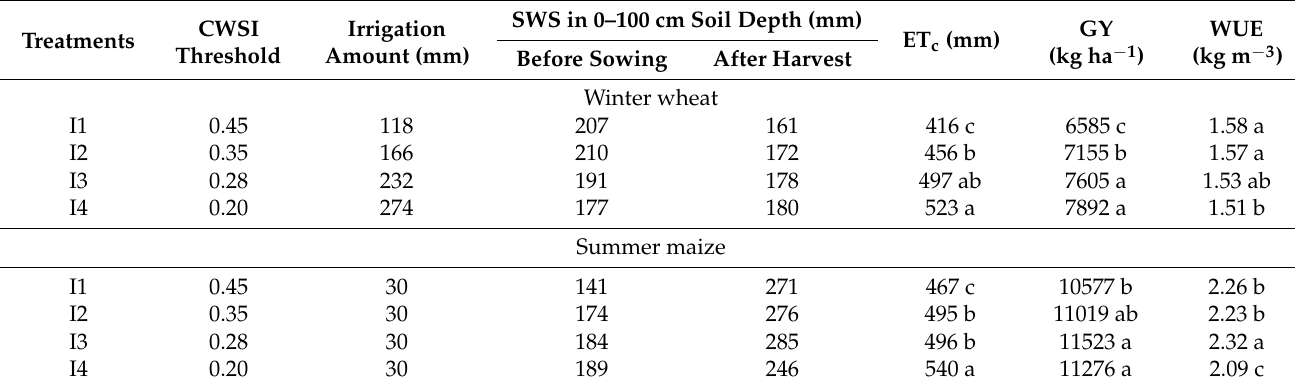
Table 2. Crop evapotranspiration, grain yield and water use efficiency of a winter wheat–summer maize cropping system with center pivot